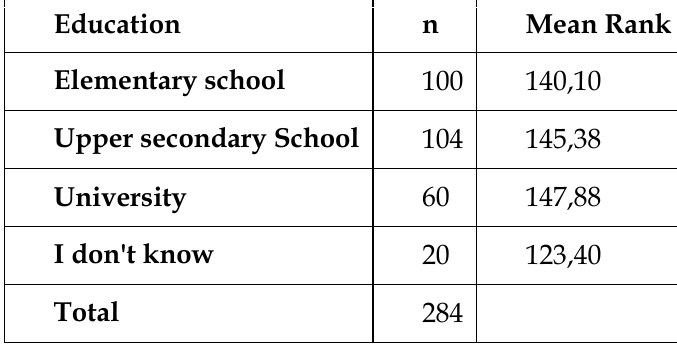
Table 10. Concern about breaching privacy and education. Kruskal-Wallis mean